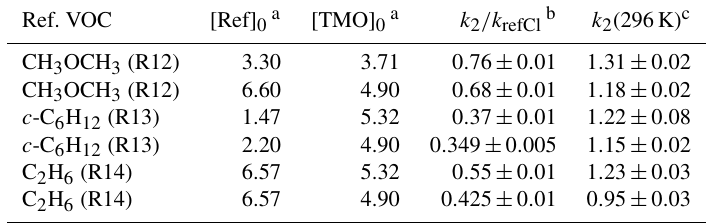
Table 4. Results from relative rate experiments to determine k 2 (296K) for Cl + TMO from this work.